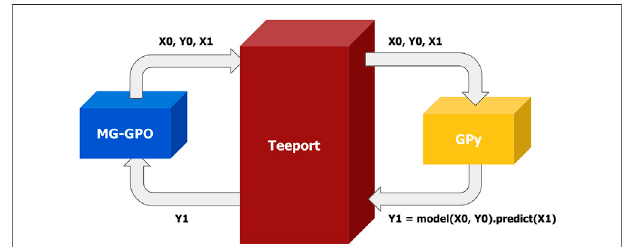
FIGURE 12 | Use the functionality from the GPy Python package in the MatlabMG-GPOalgorithmwithTeeport.Aprocessfunctionisimplementedin Python to make use of the modelling and predicting features provided by the GPy package. The needed data ( X0, Y0, X1 ) to build the GP model is passed to the processor through the Matlab version of the process function from the use_processor (id) API and the prediction ( Y1 ) is returned to the MG- GPO algorithm.